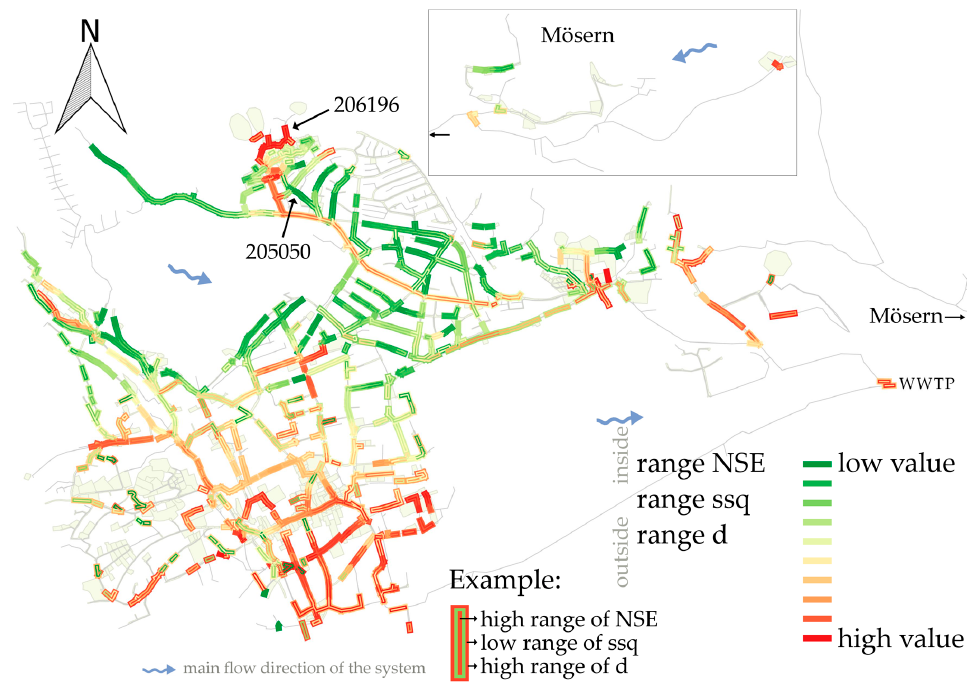
Figure 9. Range for different performance indicators resulting from random parameter variations (for simulations with real recorded rainfalls).